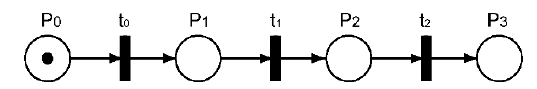
Figure 15. Petri net that describes the cross-connect process.